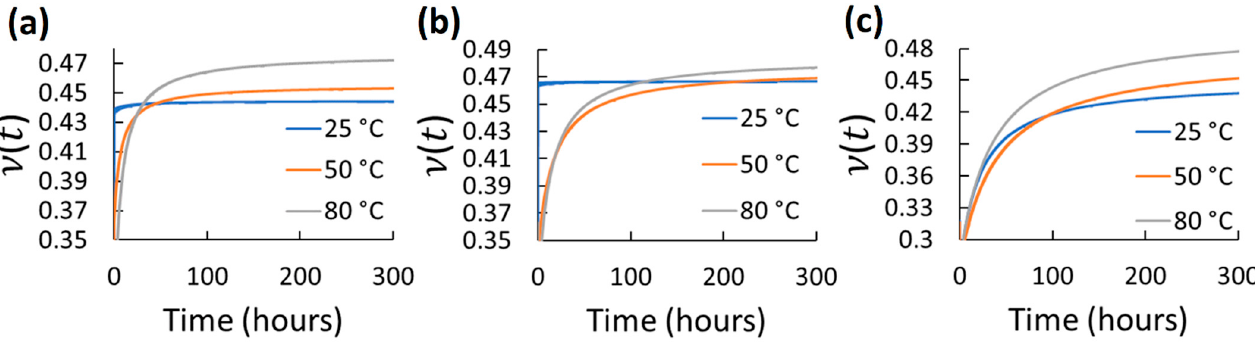
Figure 7. Viscoelastic Poisson´s ratio of VMQ at different temperatures and stress: ( a ) 200 kPa; ( b ) 400 kPa; ( c ) 600 kPa.